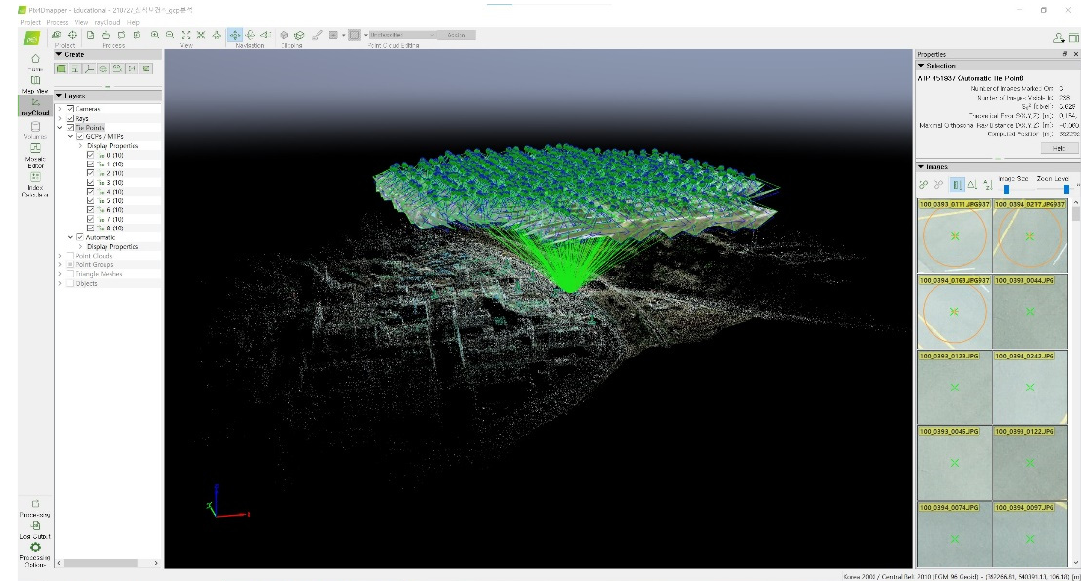
Figure 4. Pix4D Mapper.